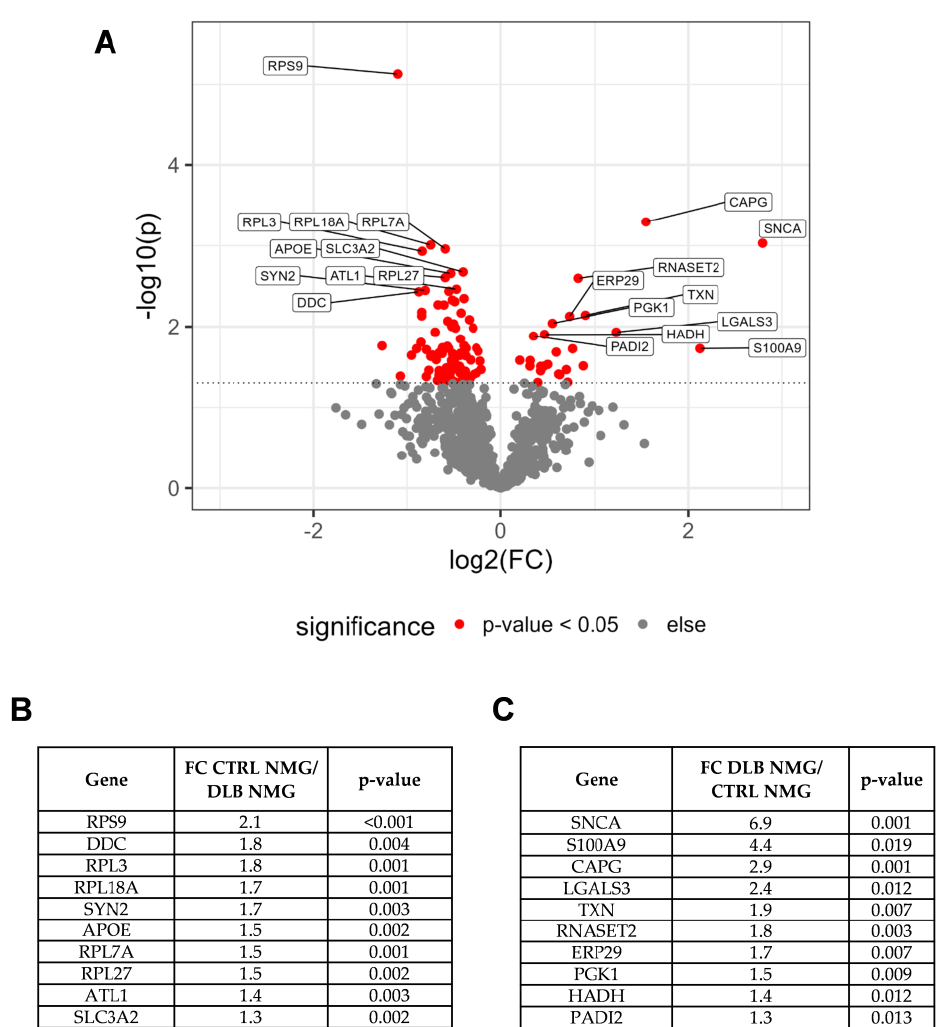
Figure 5. Results of the quantitative comparison of proteins in NMGs of CTRL and DLB cases. ( A ): Volcano plot displaying − log 10 -transformed p -values and log 2 -transformed fold changes of proteins matching the criteria for the quantitative comparison. Proteins with highest Euclidean distances on both sides are indicated with their respective gene symbols. ( B ): Summary of fold change and p -value for proteins with highest Euclidean distances and higher abundances in NMGs of CTRL cases. ( C ): Summary of fold change and p -value for proteins with highest Euclidean distances and higher abundances in NMGs of DLB cases. RPS9: 40S ribosomal protein S9; DDC: aromatic- L-amino-acid decarboxylase; RPL3: 60S ribosomal protein L3; RPL18A: 60S ribosomal protein L18a; SYN2: synapsin-2; APOE: apolipoprotein E; RPL7A: 60S ribosomal protein L7a; RPL27: